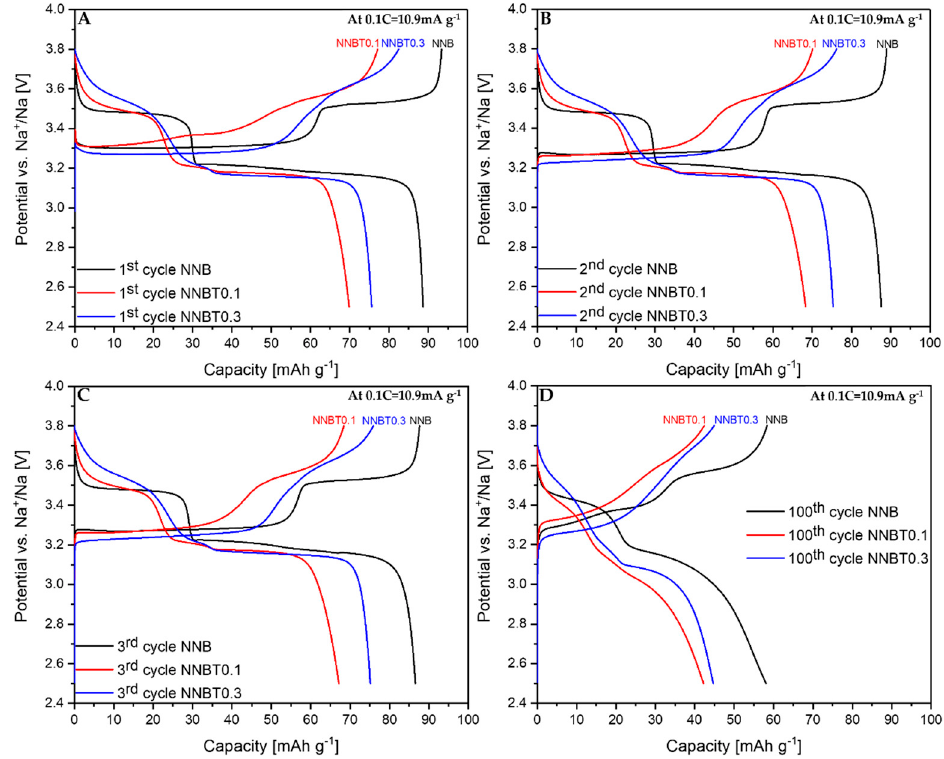
Figure 3. Galvanostatic desodiation/sodiation profiles at 0.1 C for 1st ( A ), 2nd ( B ), 3rd ( C ) and 100th ( D ) cycles of NNB, NNBT0.1 and NNBT0.3.